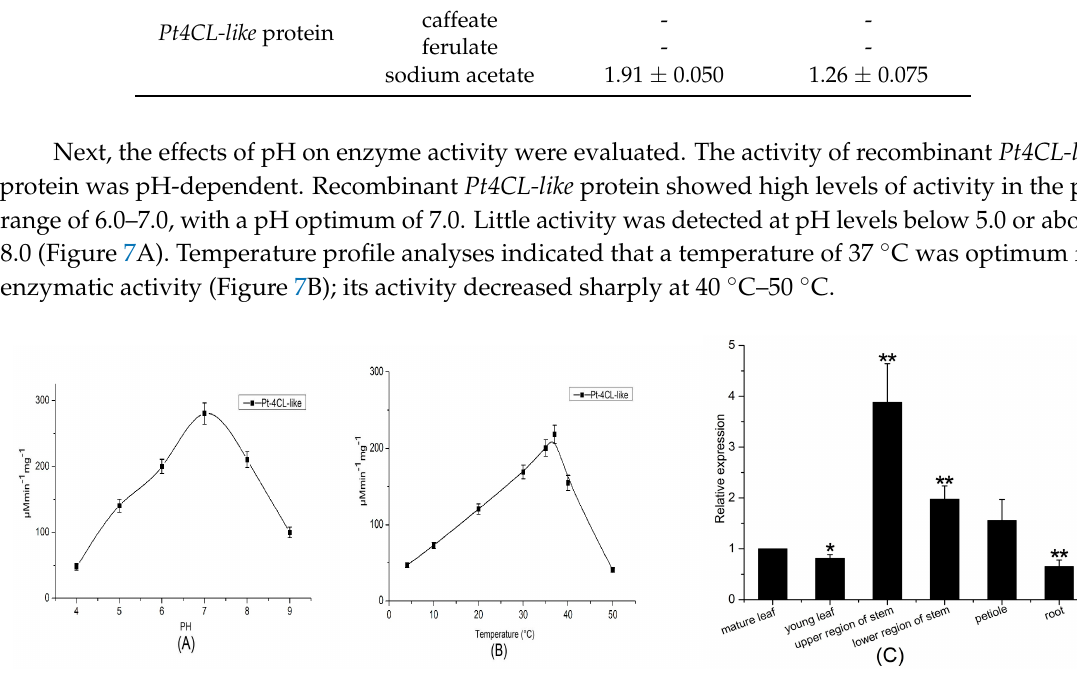
Table 3. Different substrates’ K m and V max .